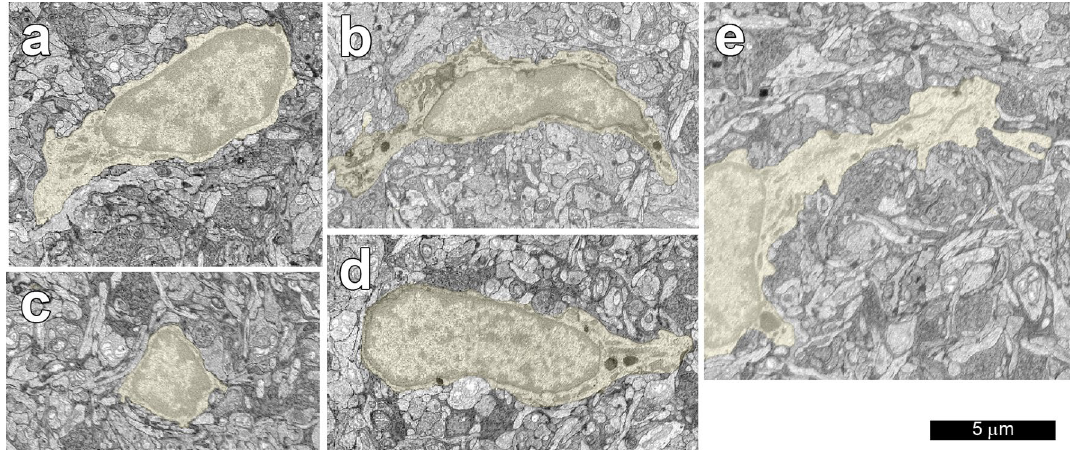
Figure 1. Microglial cell somas (yellow): ( a ) 50688, ( b ) 50640, ( c ) 50636, ( d ) 1 and ( e ) 50635. Note that a portion of the soma of cell 50635 ( e ) is not included in the volume analyzed. All of the somas were small and elongated. The shape is not apparent in the horizontal plane of section for cell 50636, but see Fig.